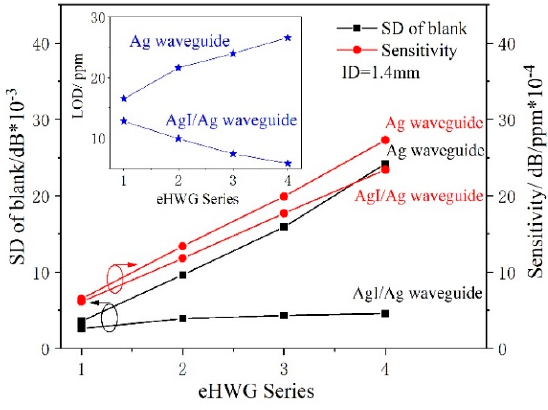
Figure 9. Sensitivity and LOD of eHWG with an Ag or AgI/Ag waveguide.